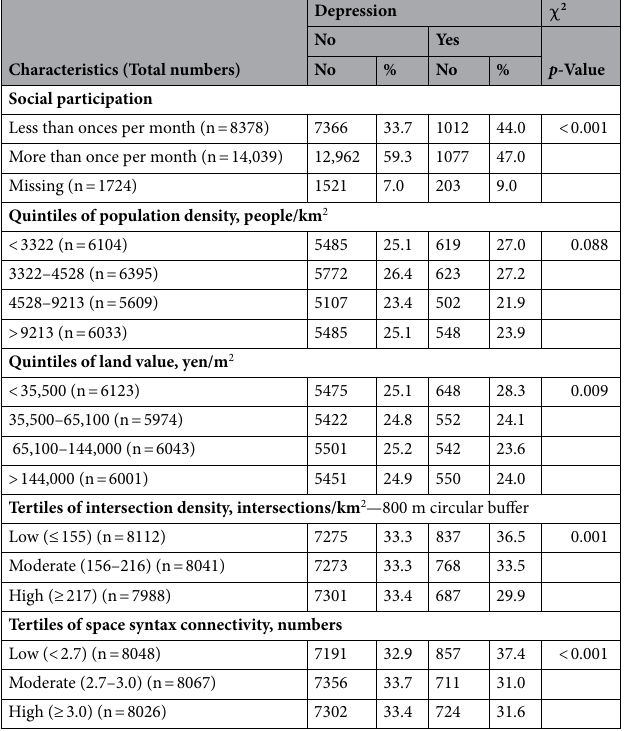
Table 1. Characteristics of the Study Participants Classified by Depression Status (n = 24,141). χ 2 chi-squared test. a How many years of formal education have you completed? 1 = Less than 6 years; 2 = 6 to 9 years; 3 = 10 to 12 years; 4 = 13 years or more; 5 = Others. b How many people are in your household, including yourself? Whom do you live with? Circle all that apply. Live by myself/Live with (1) spouse, (2) son(s), (3) daughter(s), (4) spouse(s) of child(ren), (5) grandchild(ren), (6) brother(s) or sister(s), and (7) Others. c Car user includes both self-driving and someone else drives. d How often do you go out (including to the field or immediate neighborhood, for shopping, to the hospital?) 1 . four times or more per week 2. Two or three times per week 3. Once per week 4. One to three times per month 5. Several times per year 6. Rarely. e How long do you walk a